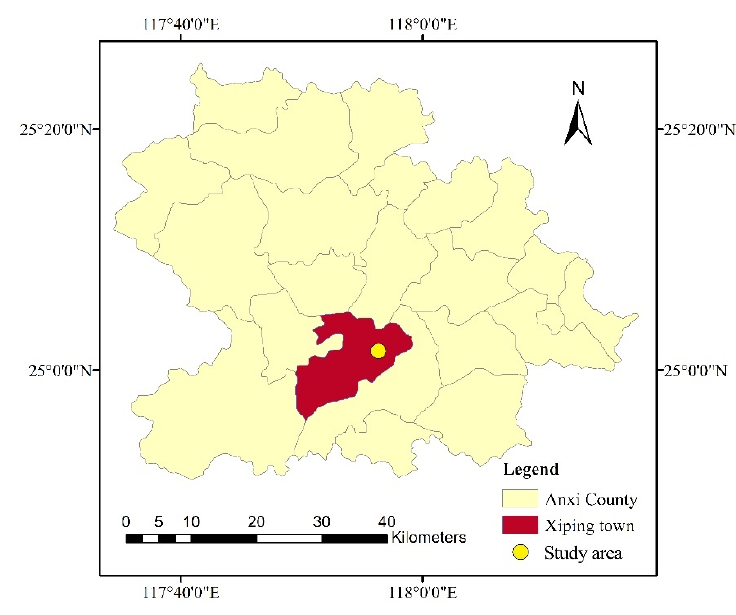
Figure 1. Location of study